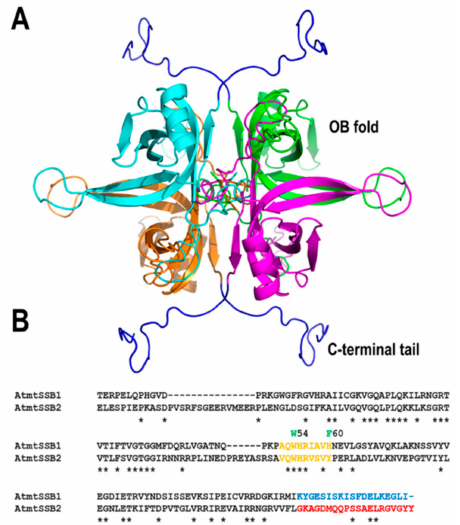
Figure 3. Homology model of tetrameric AtmtSSB1. (A ) Homology model of AtmtSBB1 illustrating its oligonucleotide / oligosaccharide / binding (OB)-fold and an acid C-terminal tail. ( B ) An amino acid sequence alignment illustrates that the C-terminal tail of AtmtSSB2 is composed of two aromatic amino acids, whereas AtmtSSB1 is